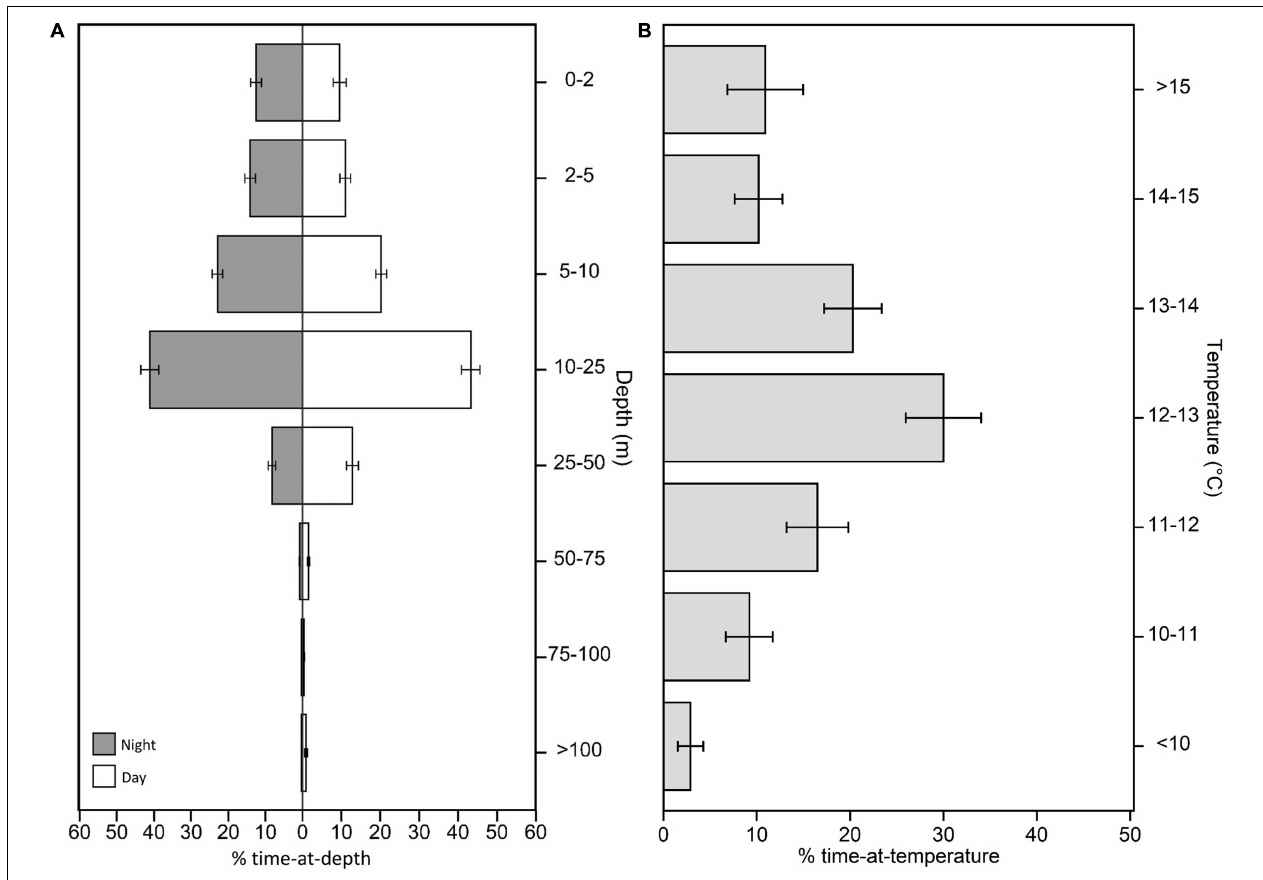
FIGURE 2 | Summarized time-series data from PSATs recovered from 32 individual white sharks Carcharodon carcharias . Summaries are from data restricted to the coastal phase of the white shark migration. (A) Percent time-at-depth for night and day-time periods. (B) Percent time-at-temperature. Note that for (A) , bin size is not equal between